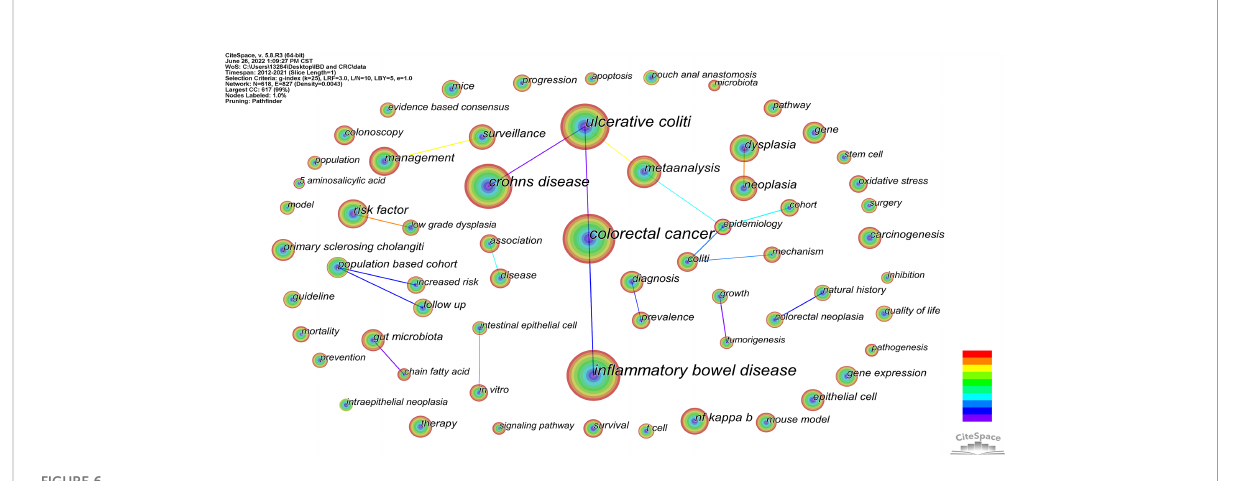
FIGURE 6 Visualization with keyword frequency more than 50.